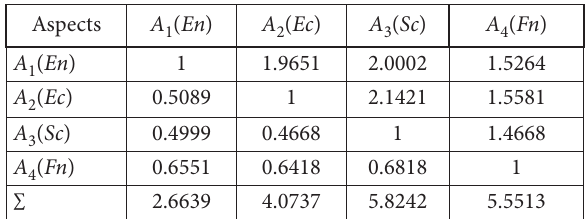
Table 6. Matrix of comparison data for sustainability aspects